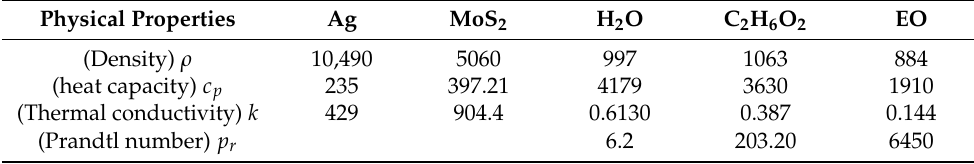
Table 5. The thermophysical properties of the nanoparticles and base fluids